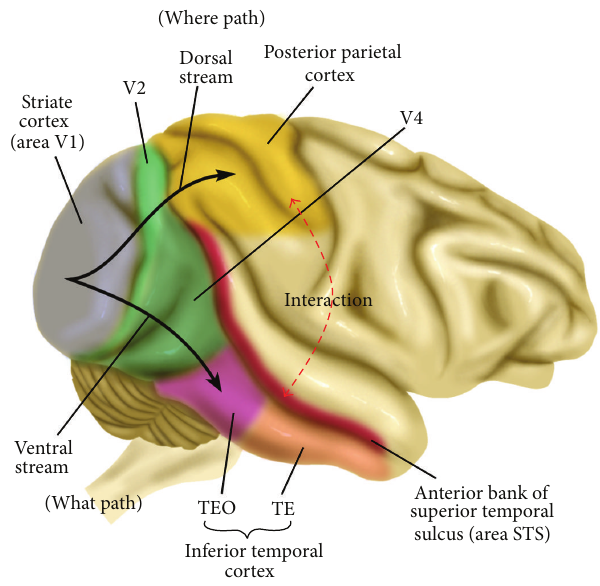
Figure 1: Structure of HVS and the interaction between where path (dorsal stream) and what path (ventral stream).